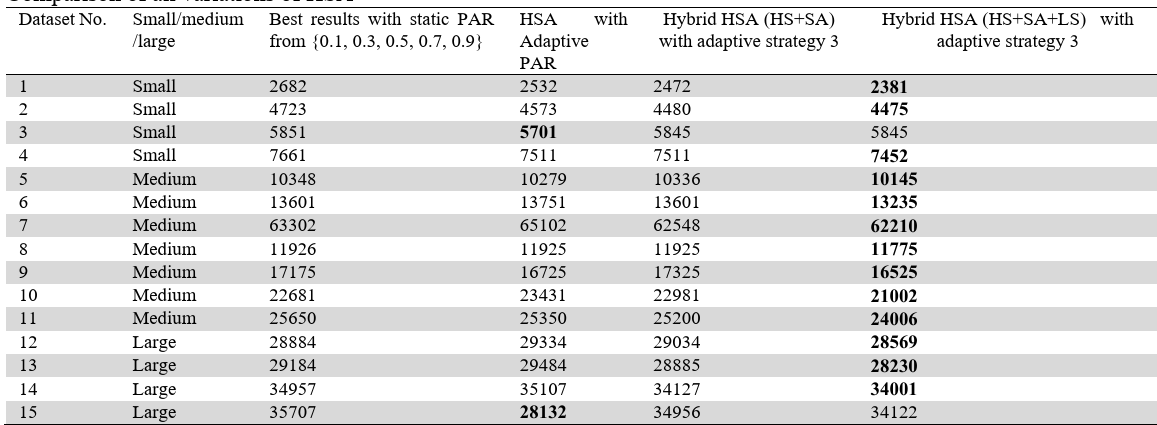
Comparison of all variations of HSA Dataset